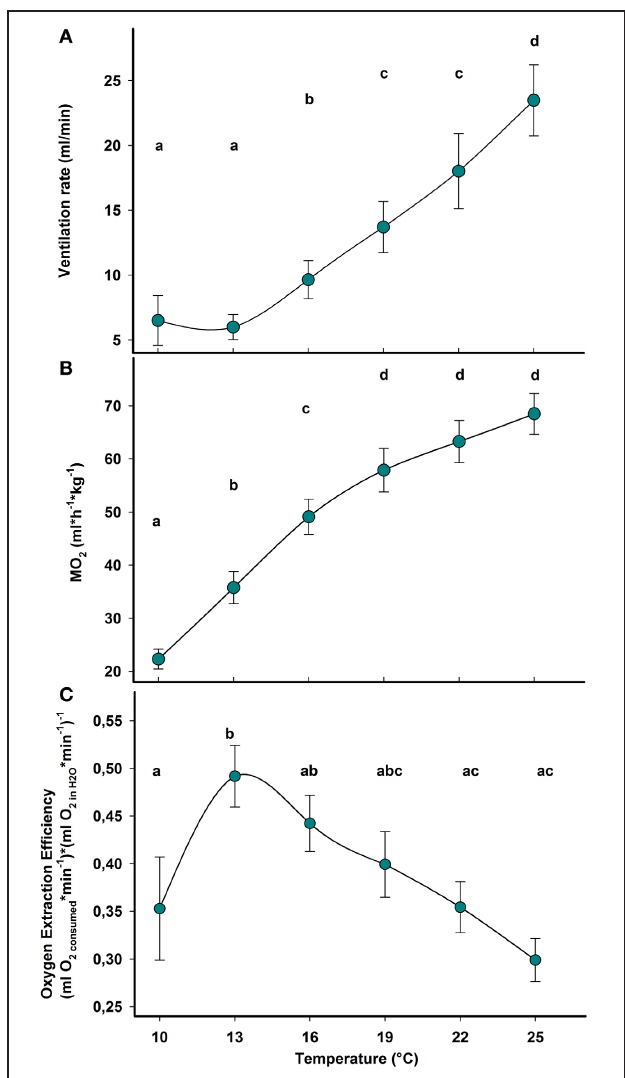
FIGURE 3 | Temperature dependent pattern of aerobic metabolism and ventilation during acute warming from 10 to 25 ◦ C. (A) Water flow expressed in volume of excurrent flow × minute − 1 . (B) Oxygen consumption rate (MO 2 ). (C) Oxygen extraction efficiency (OEE) from ventilation current. Within each panel, different letters indicate statistically significant differences between treatments (Student–Newman–Keuls test; p < 0 . 05). Data are means ± s.e.m., n =